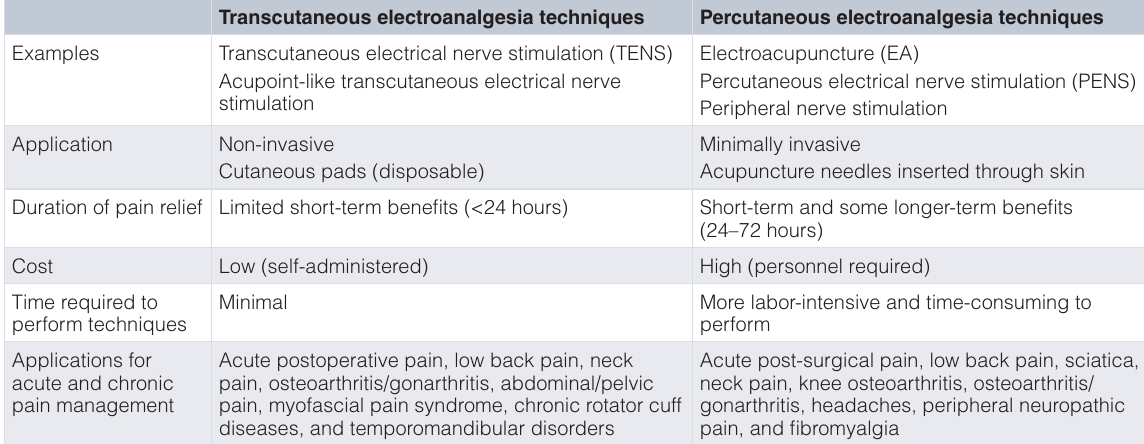
Table 1. Comparison of typical characteristics and applications of transcutaneous and percutaneous electroanalgesia techniques for treating acute and chronic